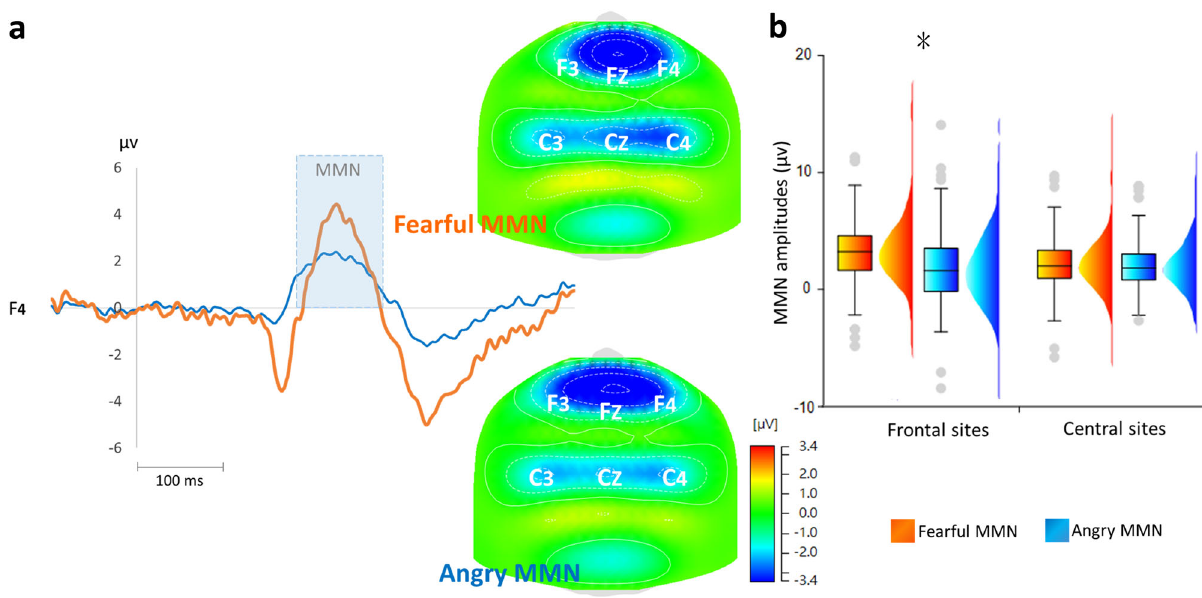
Fig. 2 Fearful and angry MMN. a Fearful and angry MMN were derived by subtracting neutral ERPs from fearful and angry ERPs, respectively. b eMMN was statistically identi fi ed by using a mixed ANOVA comprising gender (male or female) as the between-subjects factor, and the deviant type (fearful or angry), coronal site (left, midline, right) and anterior – posterior site (frontal or central) as the within-subjects factors. Fearful MMN (2.66 ± 0.27 μ V, P = 0.015) exhibited signi fi cant higher amplitudes than angry MMN (2.09 ± 0.26 μ V) in frontal electrodes but not in central electrodes (fearful MMN: 2.29 ± 0.23 μ V; angry MMN: 2.15 ± 0.2 μ V, P = 0.475). Whisker boundaries were set as box edge ± 1.5 interquartile range (IQR). Source data are presented in Supplementary Data